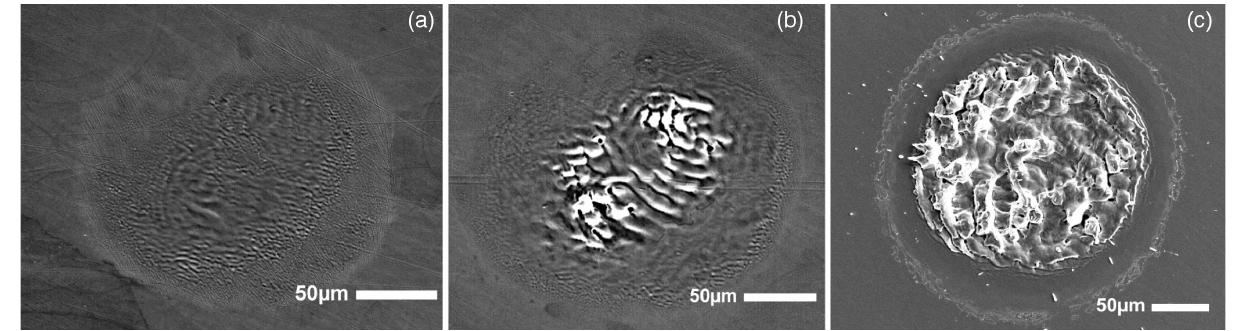
FIG. 1. SEM micrographs of the three characteristic types of craters created on the flat surface of Nb induced by a pulsed laser illumination: (a) F ¼ 0 . 68 J = cm 2 , N ¼ 120 ; (b) F ¼ 1 . 40 J = cm 2 , N ¼ 100 ; and (c) F ¼ 2 . 89 J = cm 2 , N ¼ 140